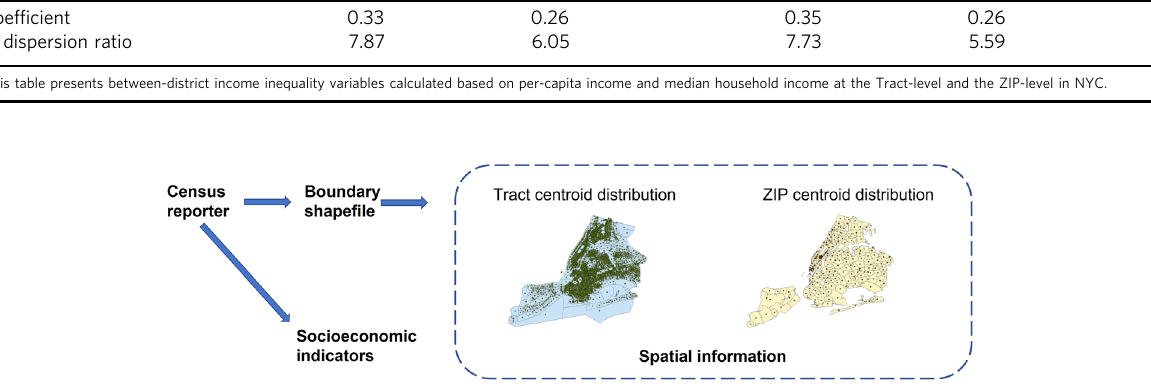
Fig. 1 Input data used in